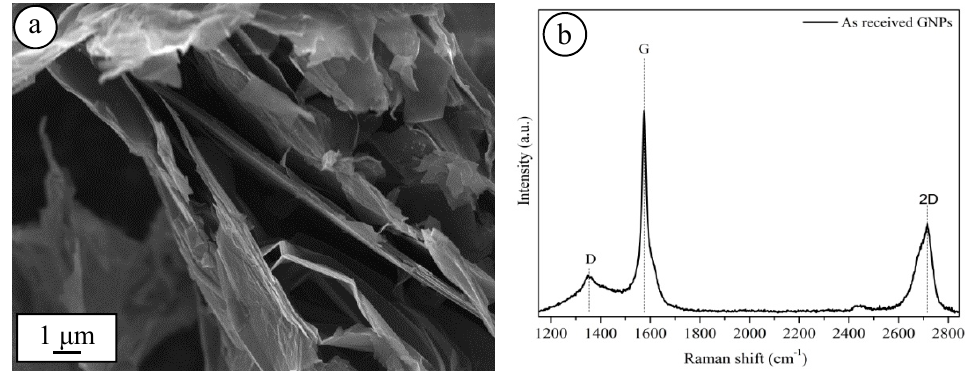
Figure 2. ( a ) SEM image and ( b ) Raman spectrum of as-received graphene nanoplatelets (GNPs).